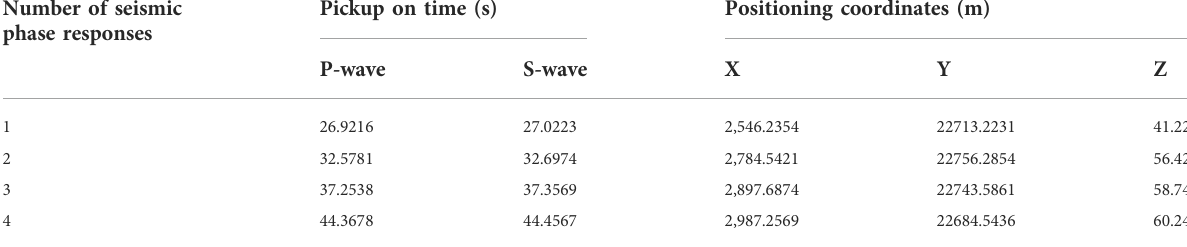
TABLE 10 Integrated software inversion of Tashan mine positioning data on April 10.